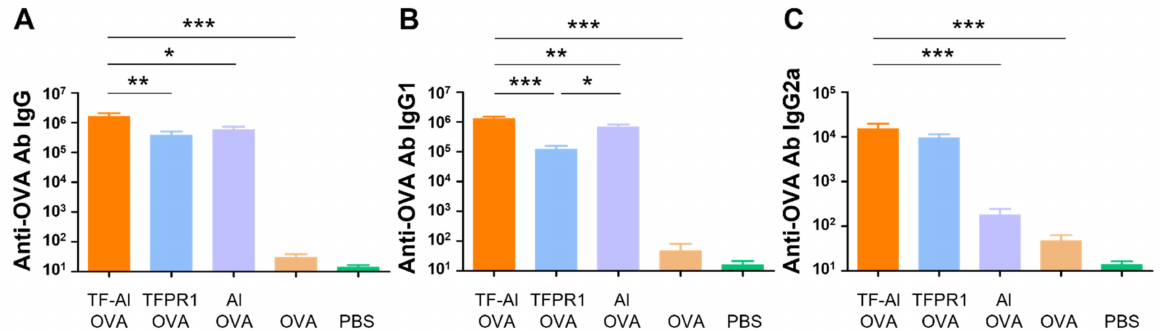
Figure 5. Anti-OVA antibodies in BALB/c mice immunized with TF–Al and OVA. BALB/c mice were immunized thrice with TF–Al and OVA, TFPR1 and OVA, alum and OVA, OVA alone or PBS intramuscularly. Anti-OVA antibodies were detected on the second week after the final immunization by ELISA. ( A ) Anti-OVA antibody IgG. ( B ) Anti-OVA antibody IgG1. ( C ) Anti-OVA antibody IgG2a. Note: * stands for p < 0.05, ** p < 0.01, and *** p < 0.001.